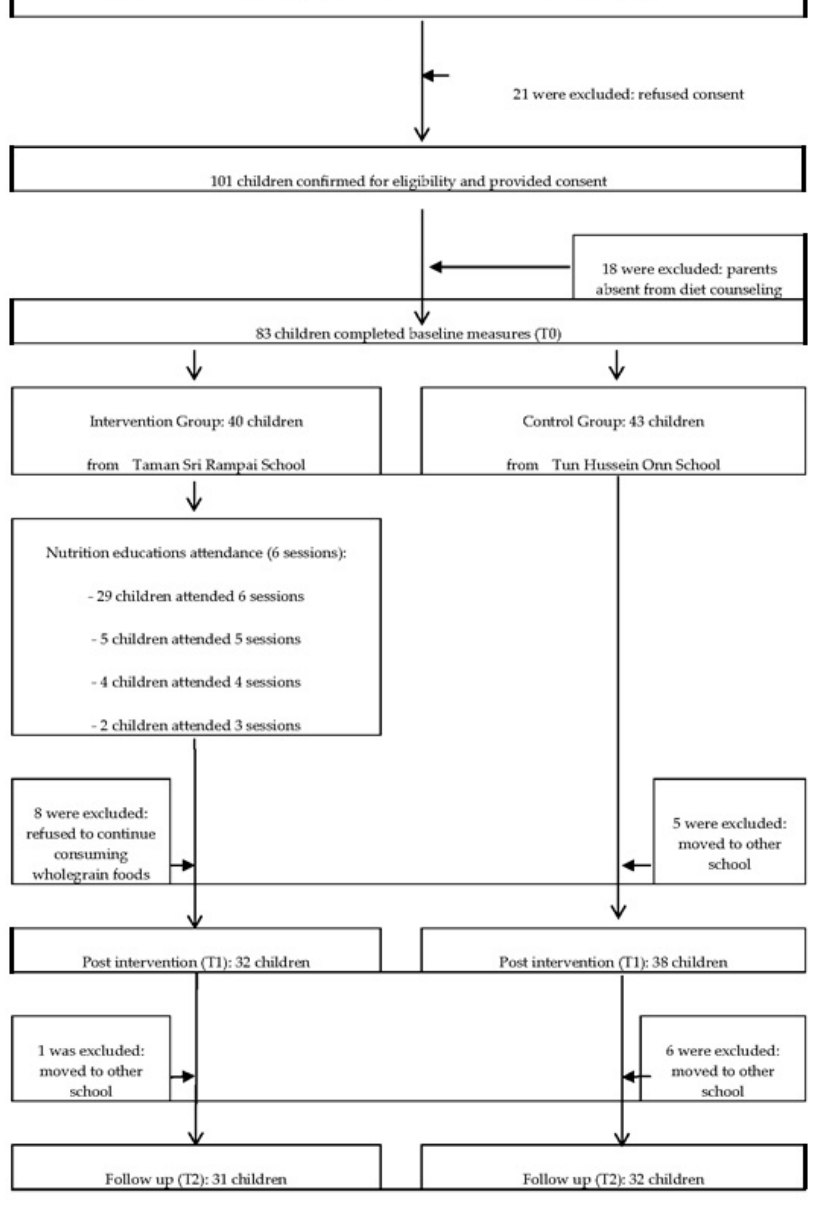
Figure 1. Flow of participants through the GReat-Child trial.